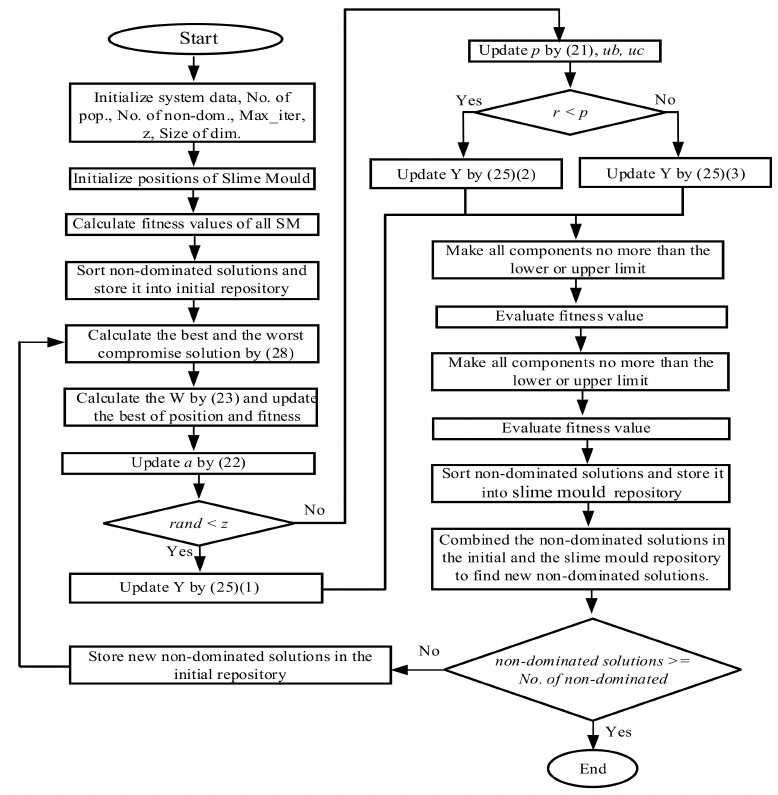
Figure 3. Flowchart of